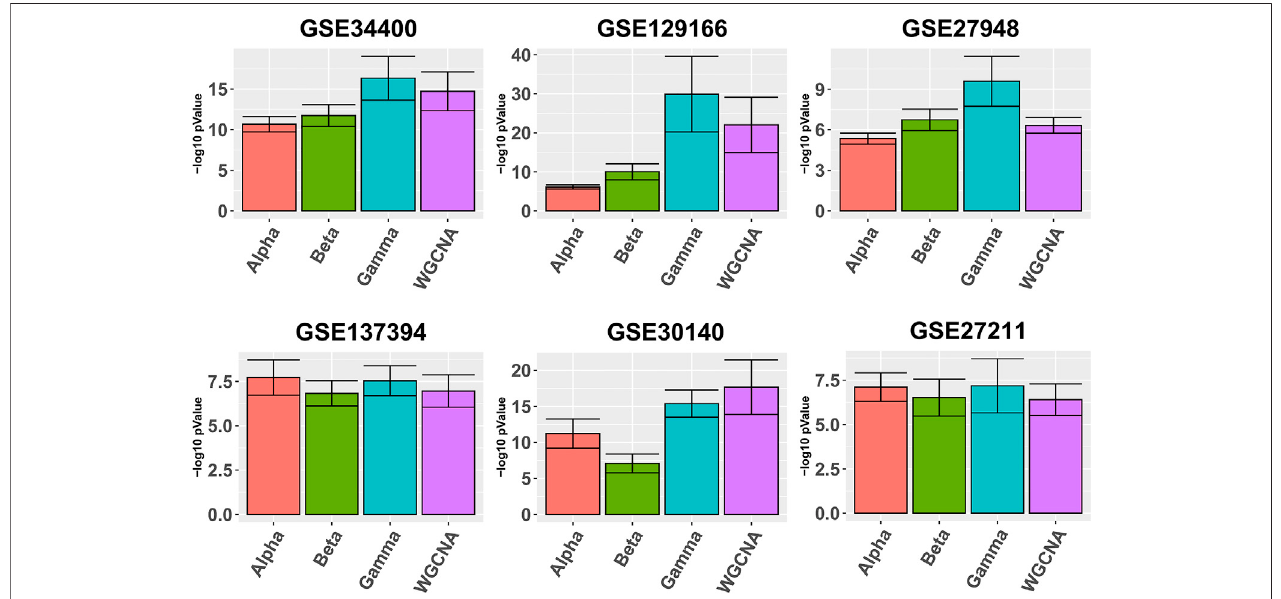
FIGURE 1 | Gene ontology enrichment analysis comparing Alpha, Beta, Gamma with WGCNA in six real data sets. The fi ve best GO enrichment p -values from all modulesarelogtransformed,averagedandshownasbarplots.Higherisbetter.Errorbarsindicatethe95%con fi denceintervalsthathavebeencalculatedbasedonthe standard deviation of the p